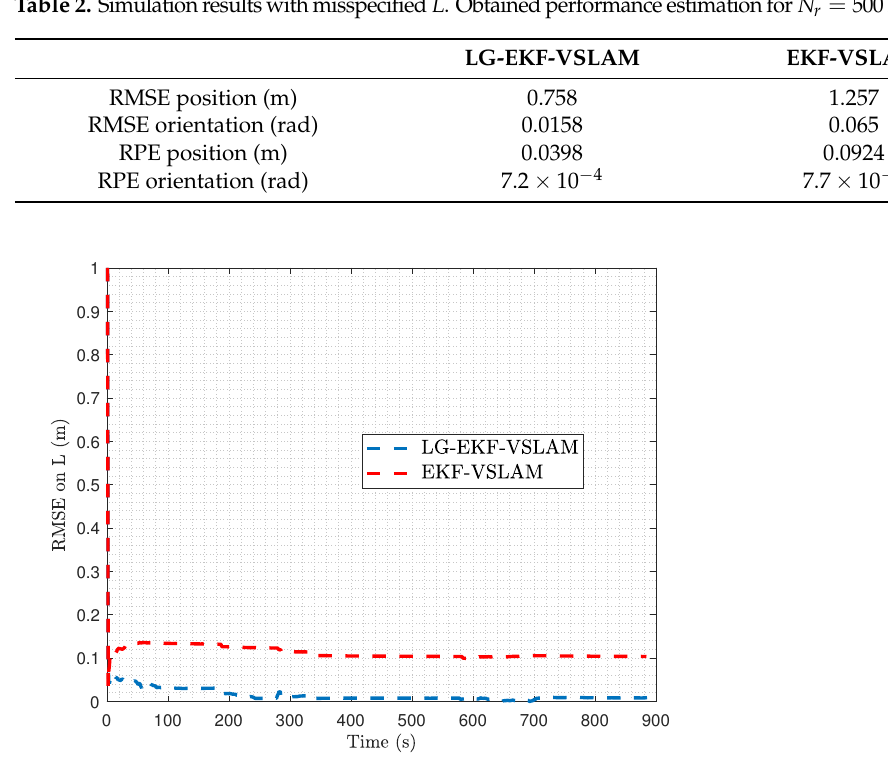
Figure 6. Evolution of the RMSE on L for Nr = 500